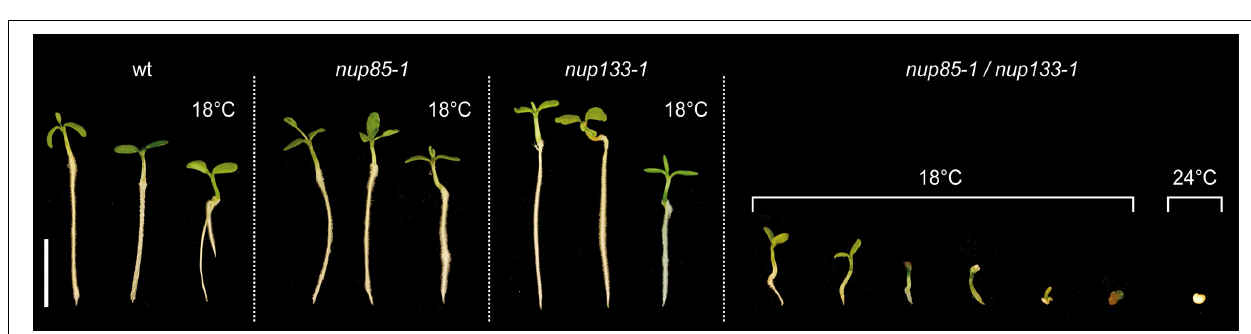
FIGURE 3 | Quantification of NUP85 and NUP133 protein levels. (A) Total protein extract from L. japonicus roots was separated by SDS-PAGE, blotted on membrane and immunolabelled with α -NUP85, α -NUP133, and α -histone H3 antibodies. (B) For quantification, signal intensities of NUP85 and NUP133